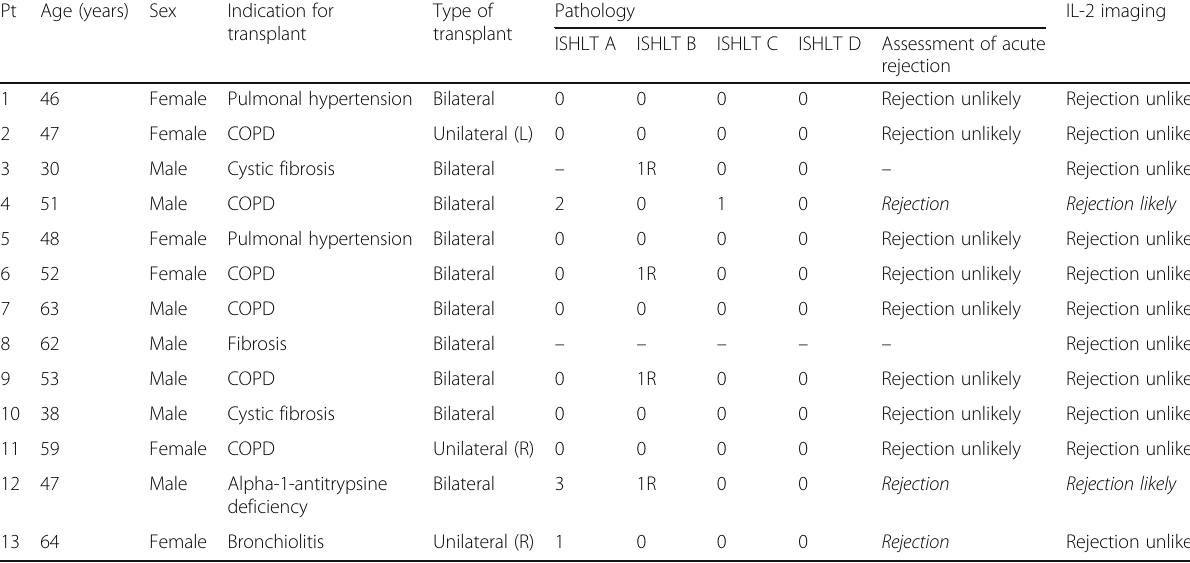
Table 1 Patient characteristics